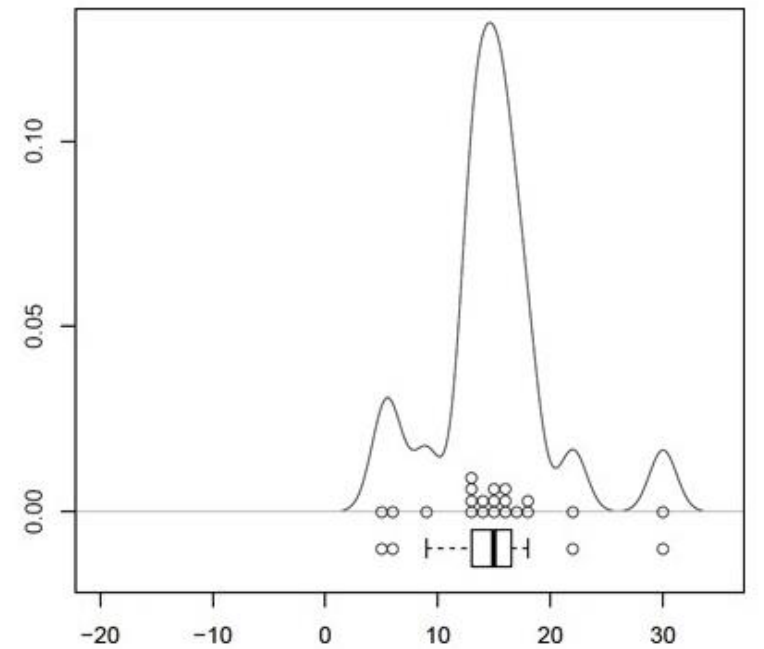
Figure 3. Visualization of the results of measurement on the left side as density-analysis. Scaling in mm. The percental spreading of the single results is displayed on the y -axis.